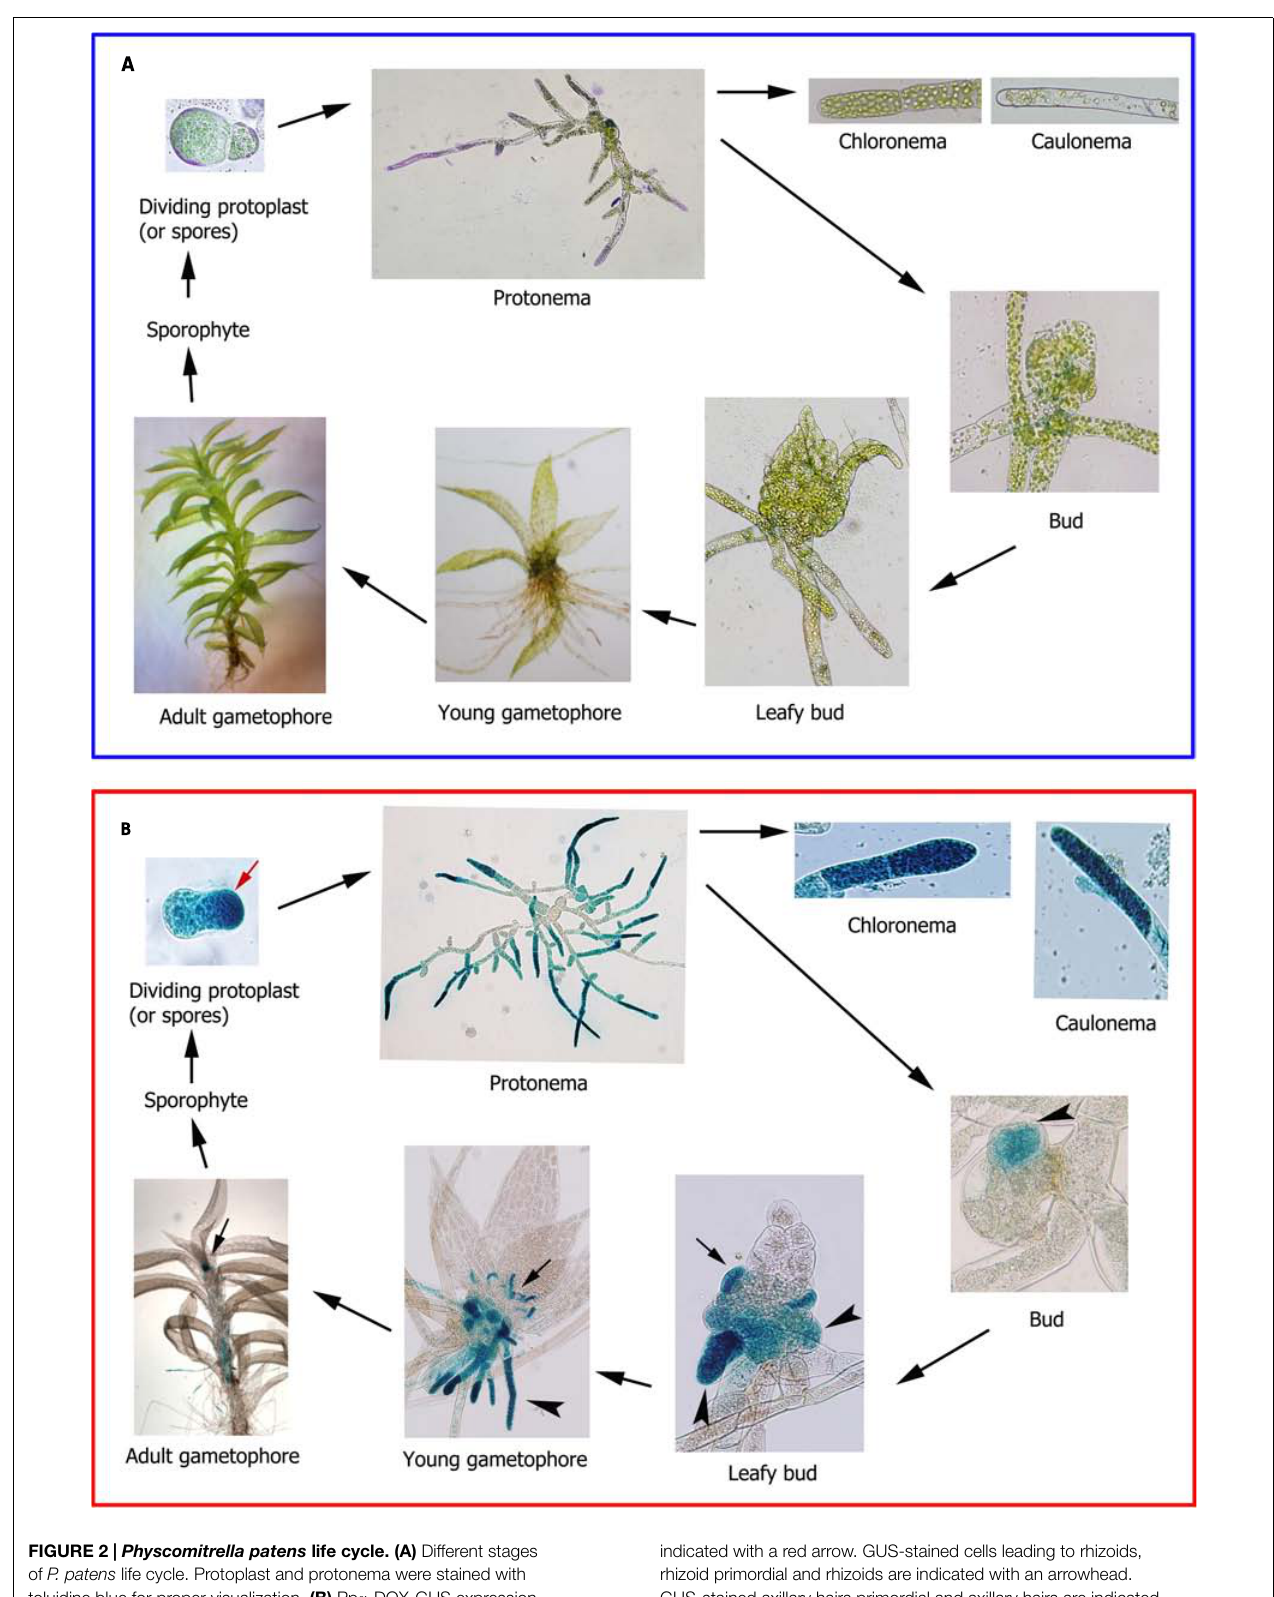
FIGURE 2 | Physcomitrella patens life cycle. (A) Different stages of P. patens life cycle. Protoplast and protonema were stained with toluidine blue for proper visualization. (B) Pp α -DOX-GUS expression during P. patens life cycle. Apical cell of a dividing protoplast is